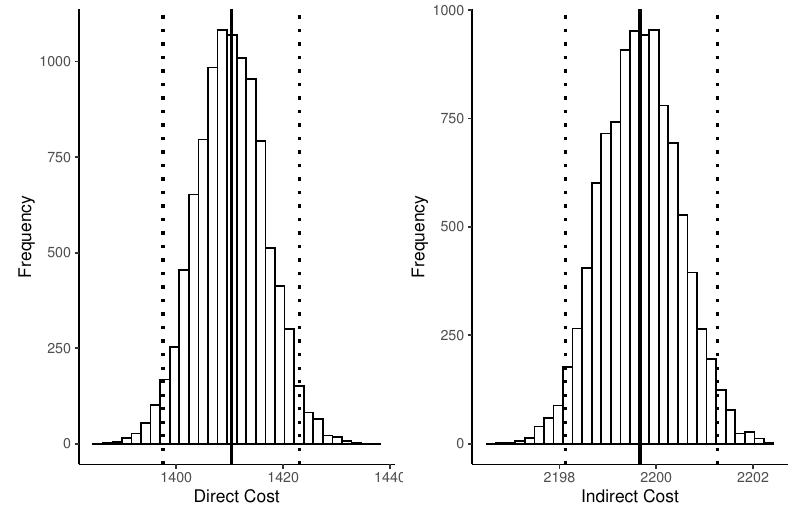
Figure 5. Sampling distribution of direct ( left ) and indirect ( right ) cost per person for 2018. Solid line indicates the mean of the distribution. Dotted lines show the lower and upper bound of the 95% prediction interval of the bootstrapping